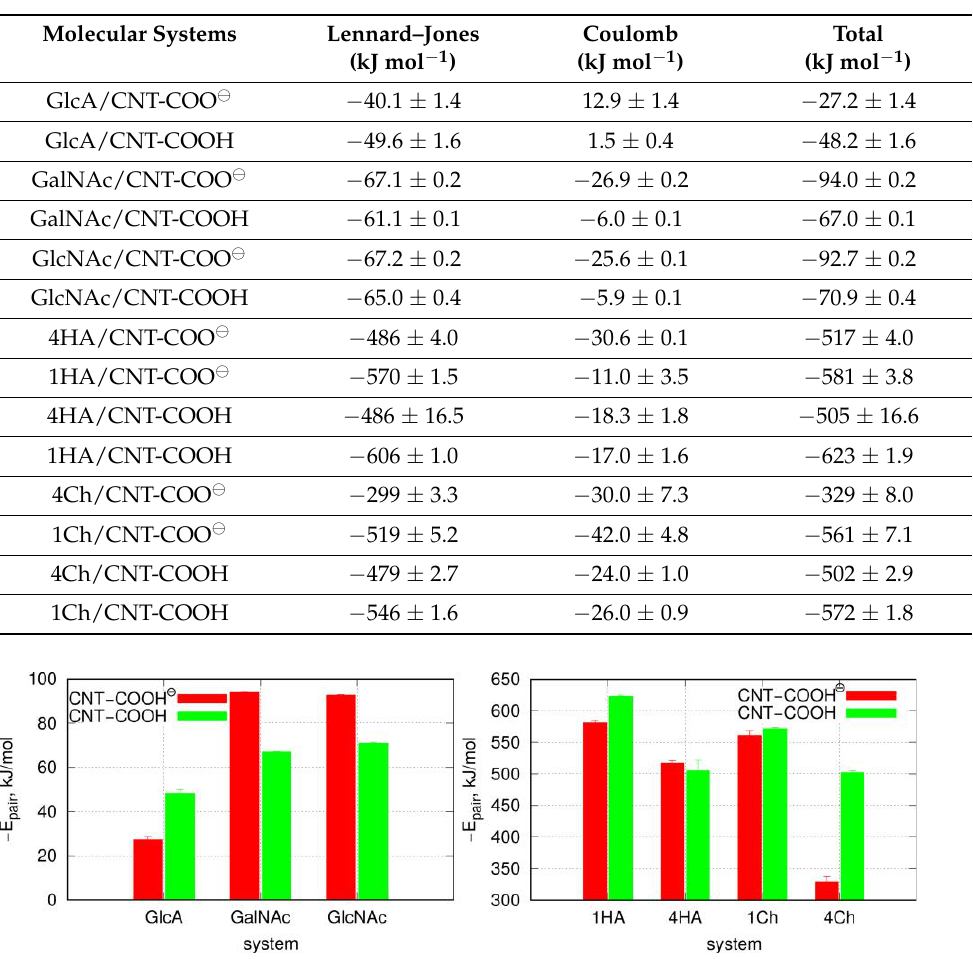
Table 1. Mean-pair-interaction energies between the fCNT and the carbohydrate molecules. The energies are calculated per single carbohydrate molecule and expressed in kJ mol − 1 . The energies are split into the Lennard–Jones and the Coulomb contributions.